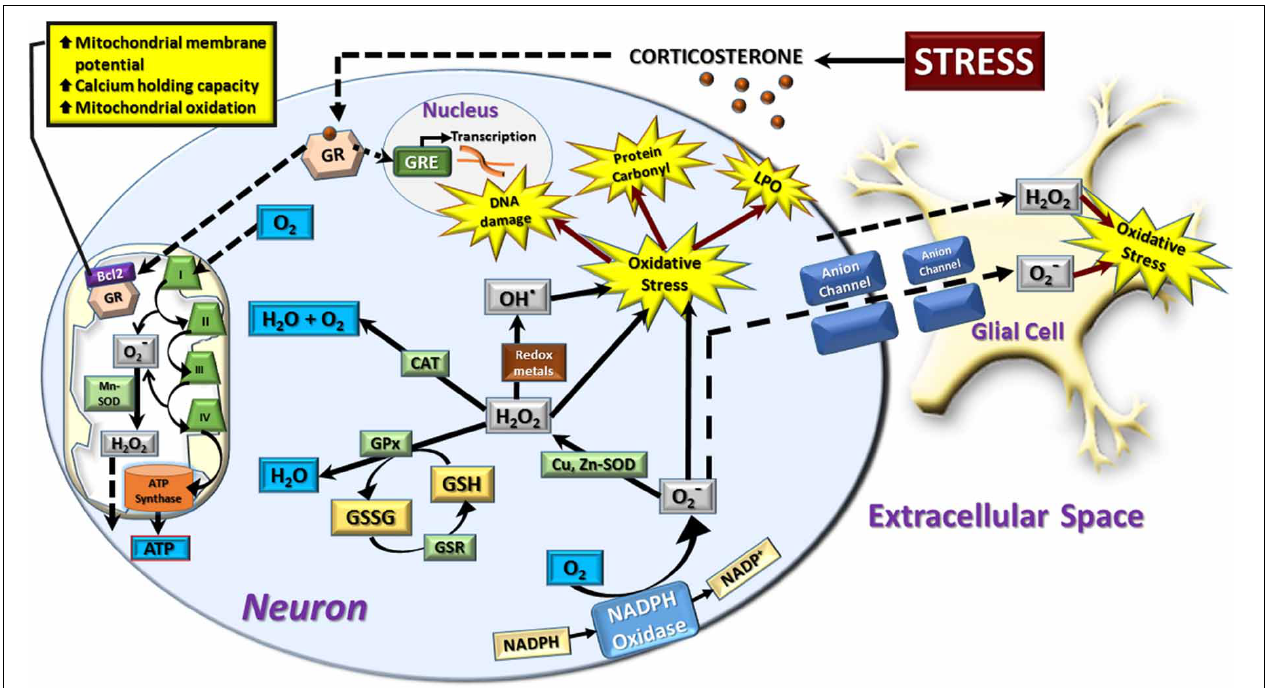
FIGURE 1 | Schematic representation of neural redox reactions. Stress causes an increase in corticosterone which activates cytosolic glucocorticoid receptors (GR). These translocate into the nucleus to modulate gene transcription through glucocorticoid responsive elements (GRE), or co-localize with the anti-apoptotic Bcl-2 protein and translocate into the mitochondria. This increases mitochondrial membrane potential, calcium holding capacity, and mitochondrial oxidation. The increase in cellular metabolic rate promotes ATP synthesis in addition to spontaneous superoxide (O − 2 ) production via complex I and III of the electron transport chain. This is dismutated to hydrogen peroxide (H 2 O 2 ) by manganese superoxide dismutase (Mn-SOD) and can be further converted to hydroxyl radical (OH − ) or reduced to water by the mitochondrial antioxidant pathway. In the cytosol, a major source of superoxide production is via the oxidation of NADPH via NADPH oxidase. Cytosolic superoxide is dismutated to hydrogen peroxide by copper, zinc-superoxide dismutase (Cu, Zn-SOD). Hydrogen peroxide is neutralized by catalase (CAT) or glutathione peroxidase (GPx) which oxidizes the reduced form of glutathione (GSH) to oxidized glutathione (GSSG). GSH is then